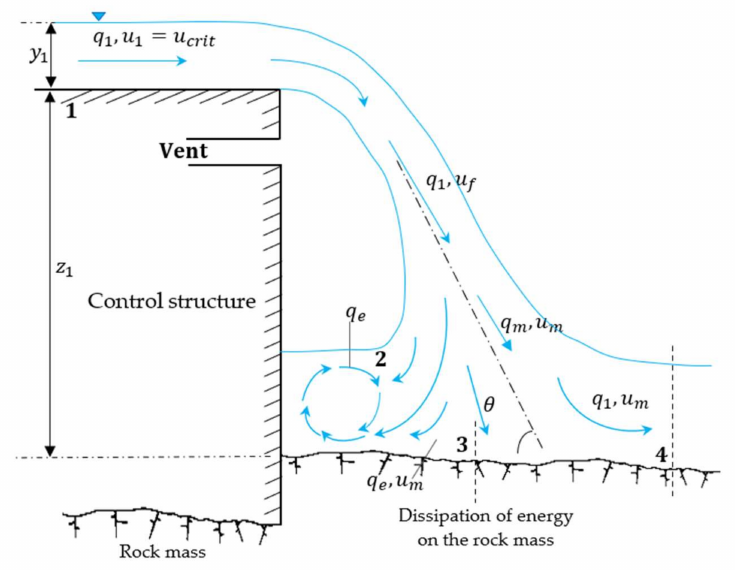
Figure 11. Schematic of a plunging flow according to Pells